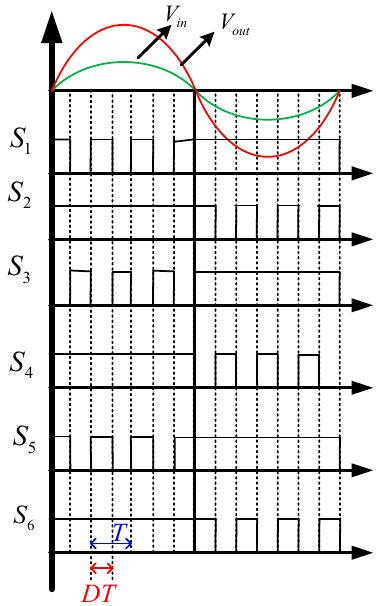
Figure 7. Operation states of the converter when in V < 0: ( a ) Non-shoot through state; ( b ) Shoot through state.